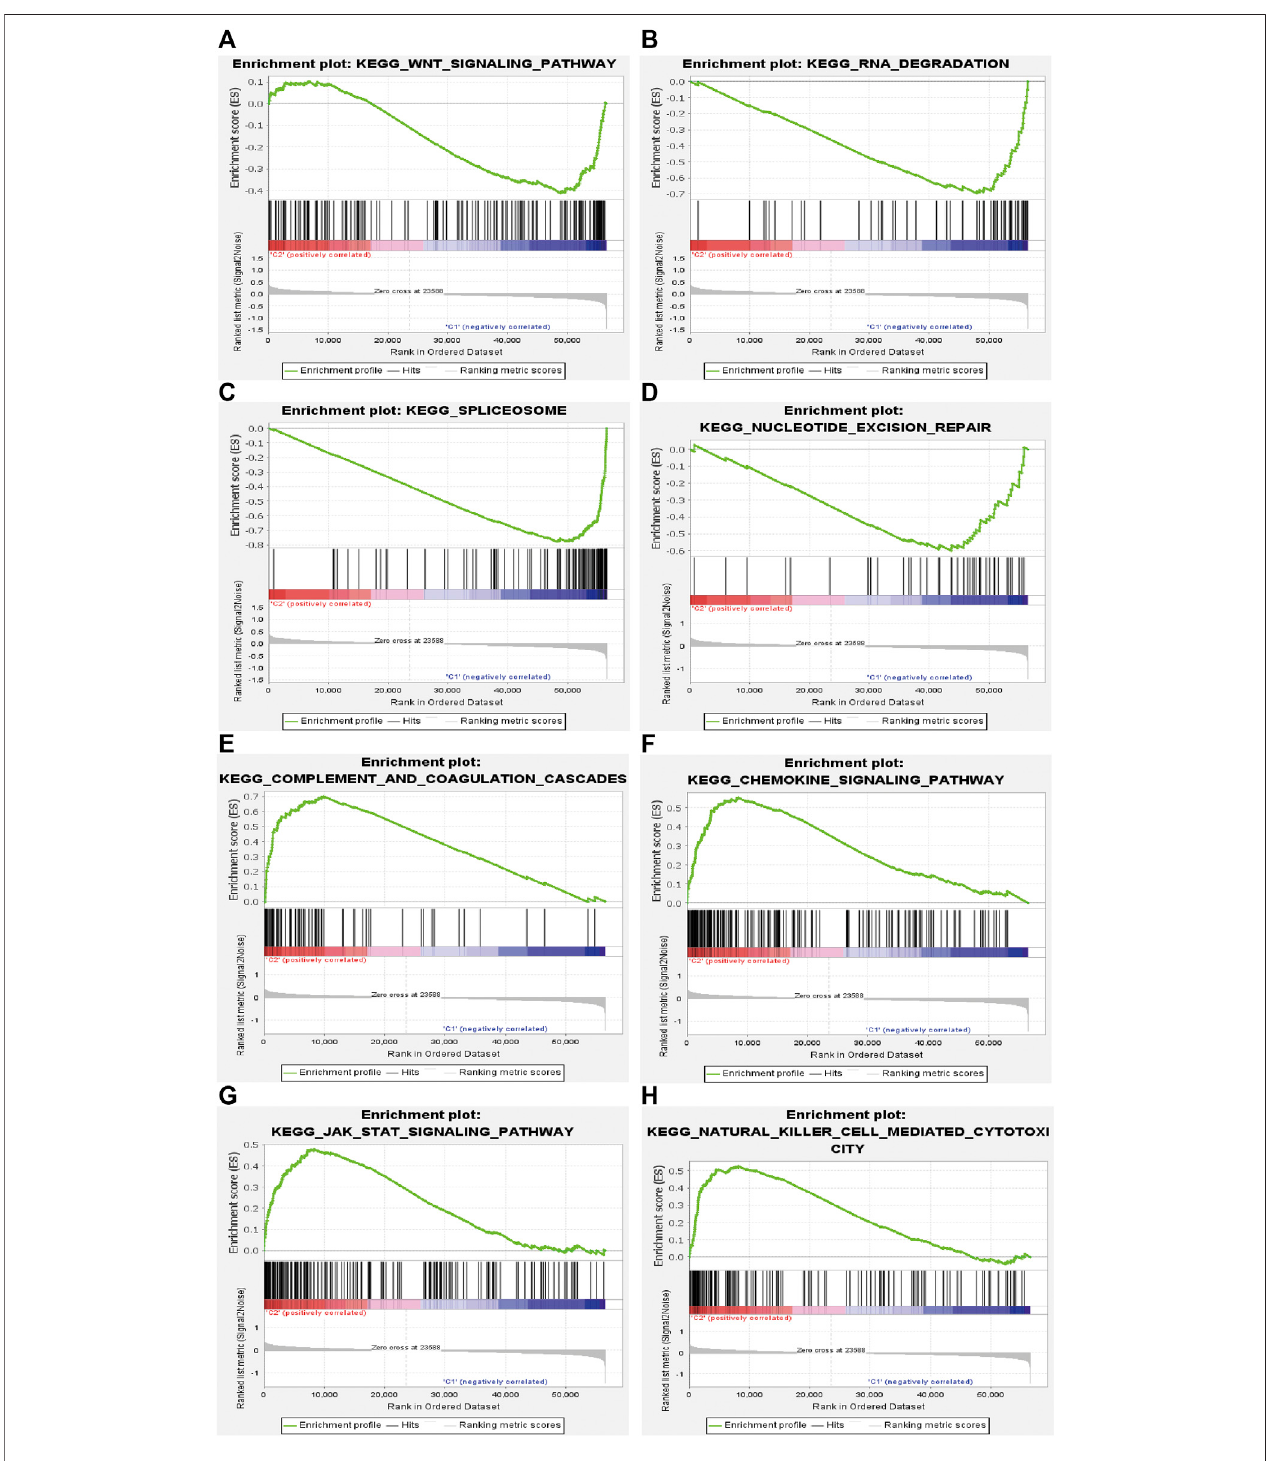
FIGURE5| Genesetenrichmentanalysis(GSEA)incluster1andcluster2. (A) WNTsignalingpathway, (B) RNAdegradation, (C) spliceosome,and (D) nucleotide excisionrepairwereenrichedincluster1. (E) complementandcoagulationcascades, (F) chemokinesignalingpathway, (G) JAK/STATsignalingpathwayand (H) NKcell mediated cytotoxicity were enriched in cluster